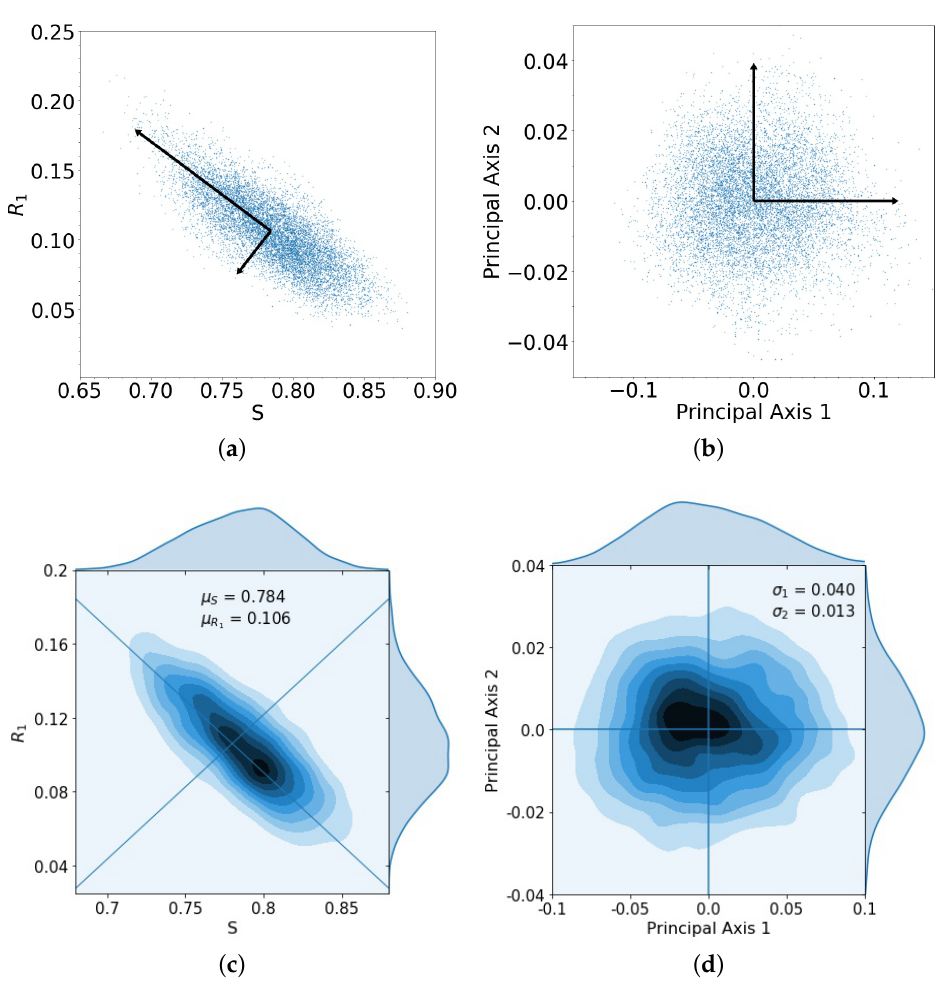
Figure 3. ( a ) Spread of 10,000 trials starting at initial conditions S = 0.8, R 1 = 0.1, and R 2 = 0.1 with principal axis after 1 loop; ( b ) same spread of trials from ( a ) plotted with principal component axes; ( c ) kernel density estimation (KDE) for trials in ( a ), with darker areas indicating a higher concentration of data, with means µ S = 0.784, µ R 1 = 0.106; ( d ) the spread of trials closely resembles a multivariate Gaussian distribution composed of the principal components, with singular values σ 1 = 0.040, σ 2 =